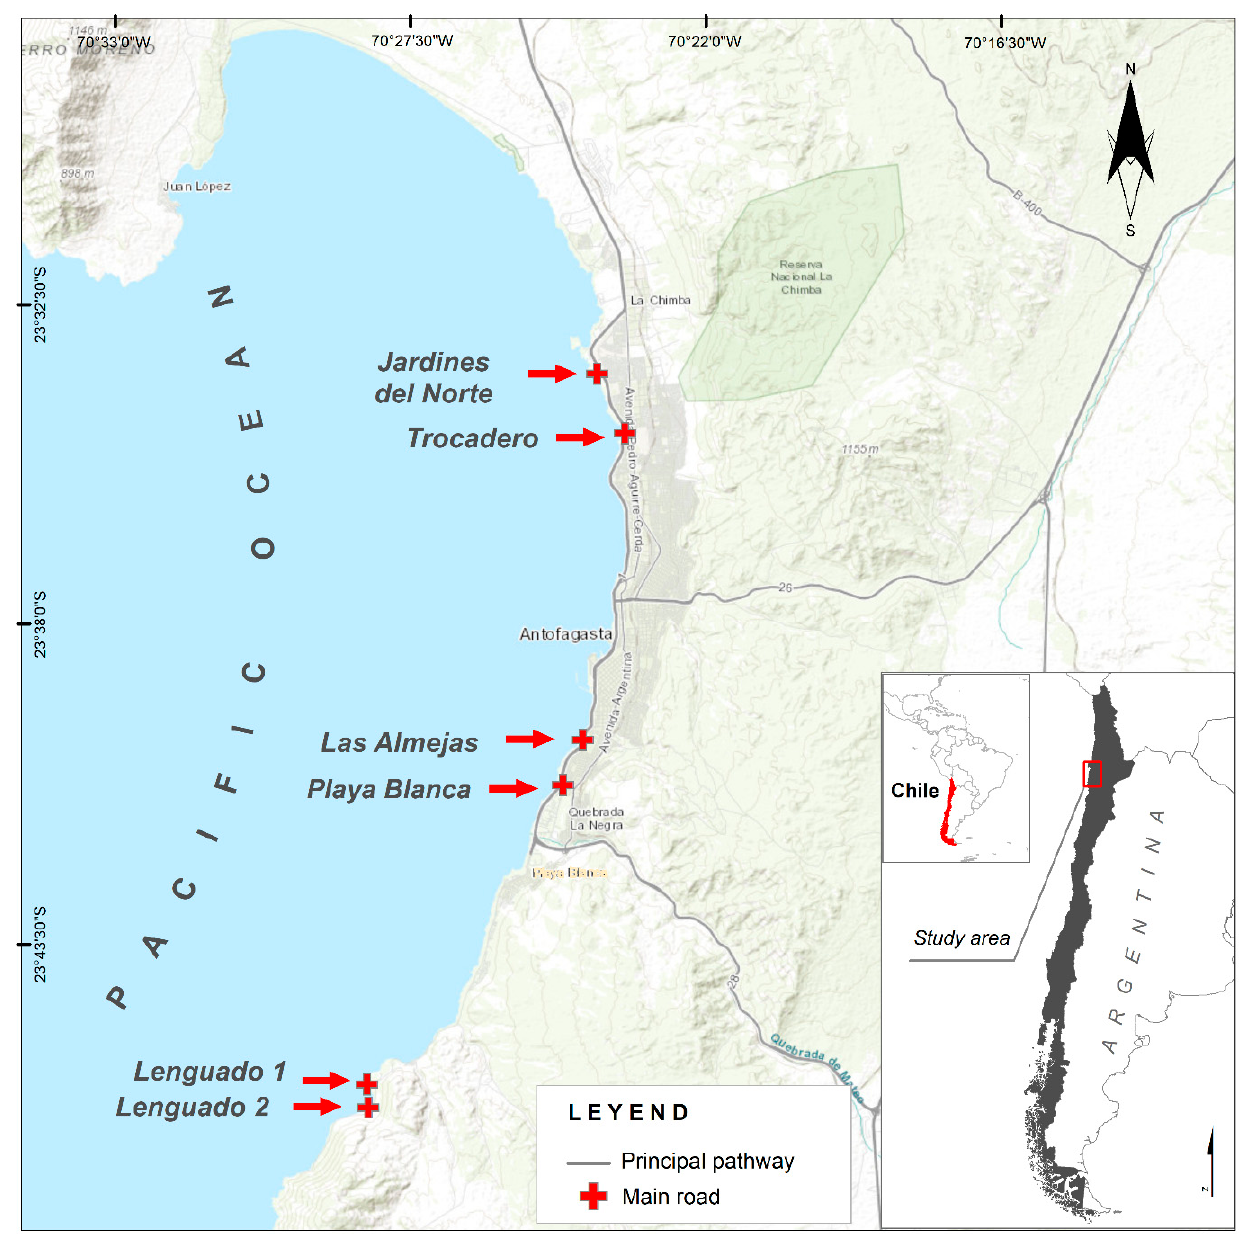
Figure 1. Map of sites (red arrows and red rectangle) included in the present study; LEGEND: Main road.